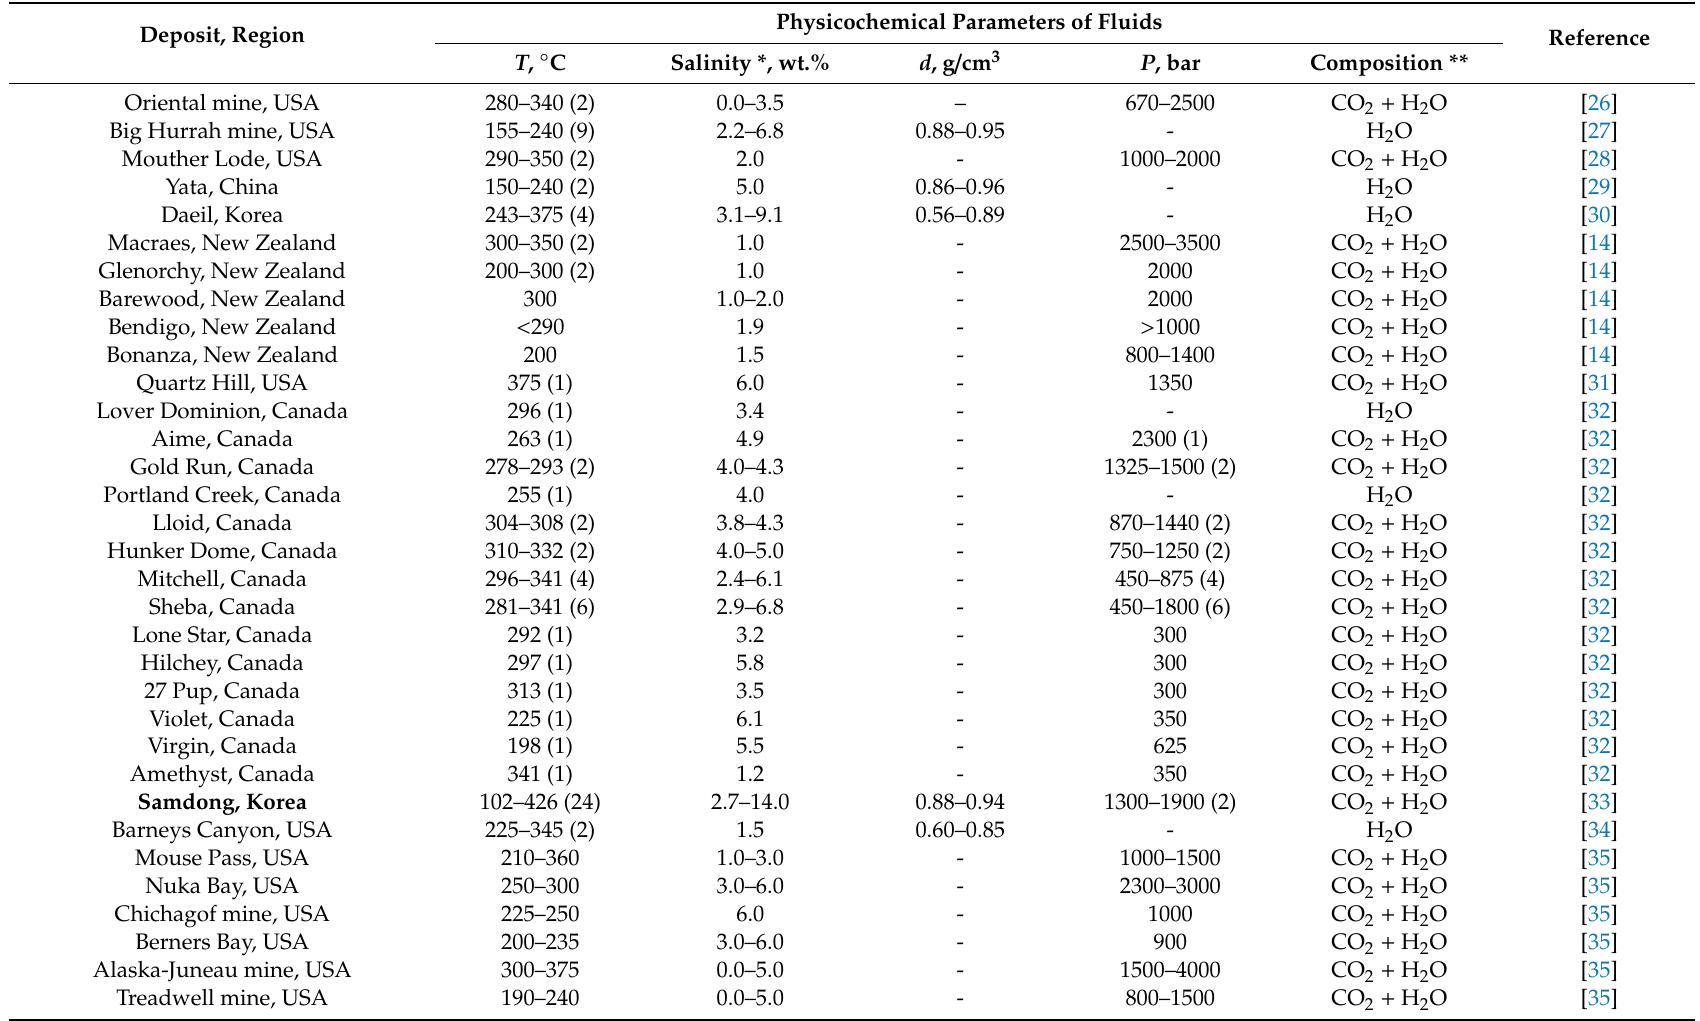
Table 3. Parameters of mineralizing fluids of Mesozoic gold